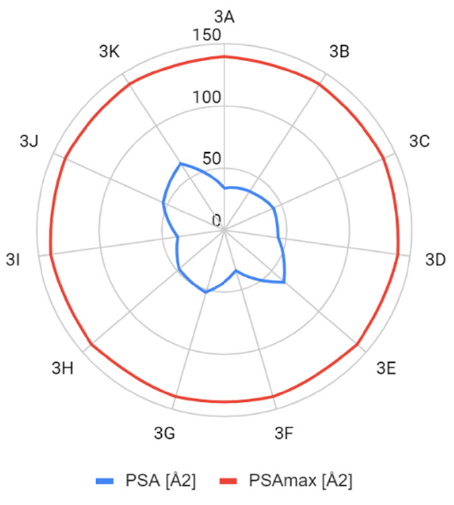
Figure 8. Comparison of polar surface area (PSAmax—maximal polar surface area that satisfies Veber’s rule).